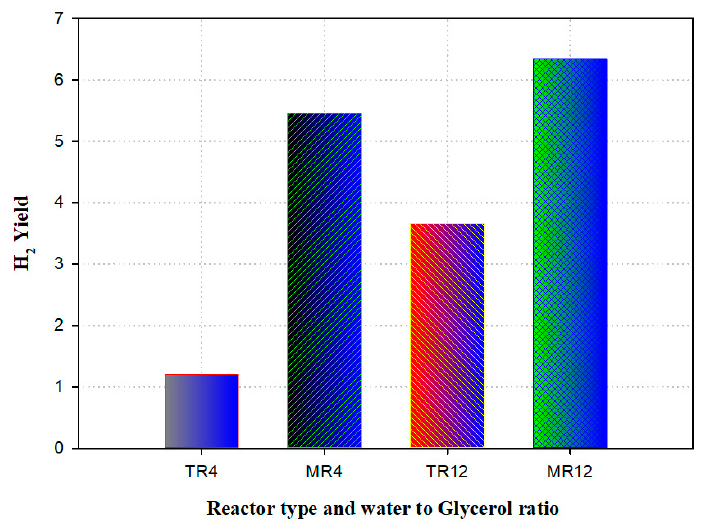
Figure 10. Hydrogen yield generated from traditional (TR) versus membrane reactor (MR) at various temperatures and water-to-glycerol feed ratio (4 and 12). Reproduced from [92].